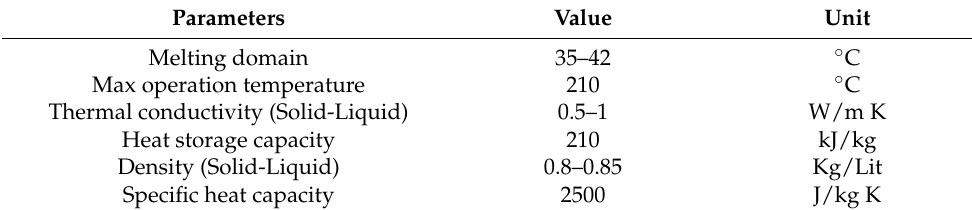
Table 3. The main features of the PCM-graphite are adapted from [17].